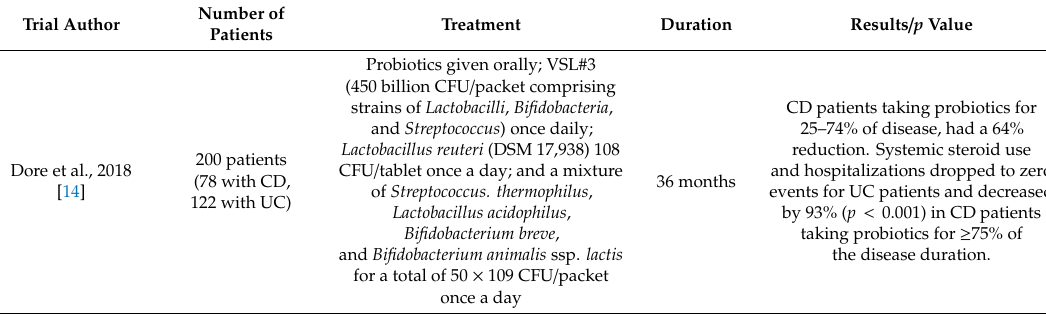
Table 1. Summary of trials examined for e ff ectiveness of probiotics on